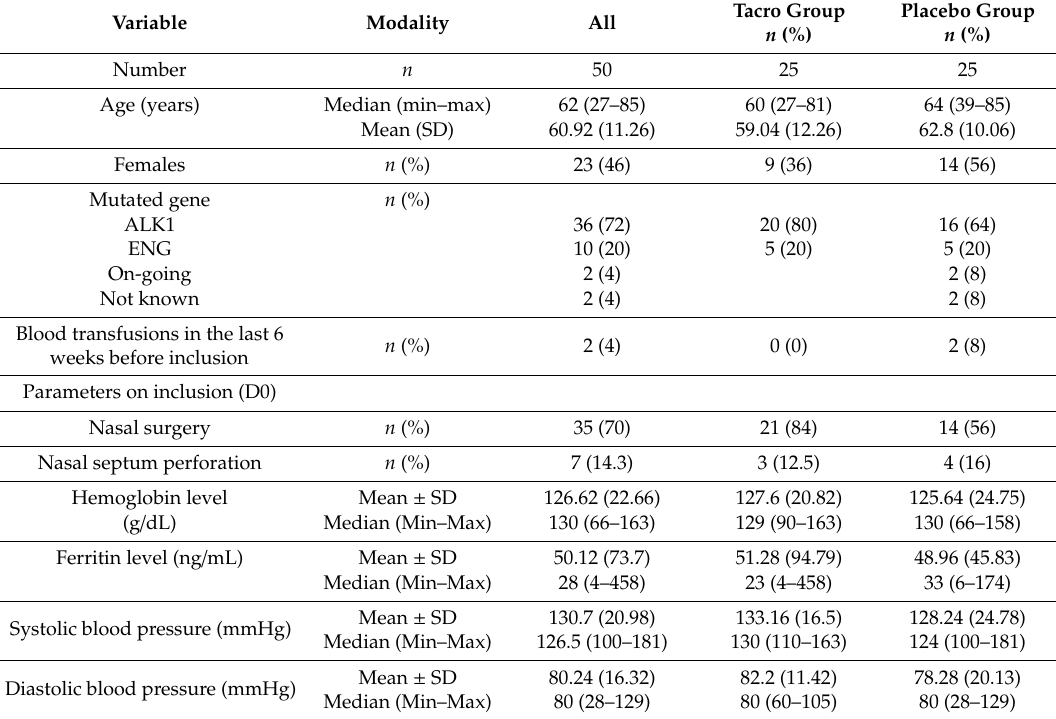
Table 1. Patient characteristics before treatment.